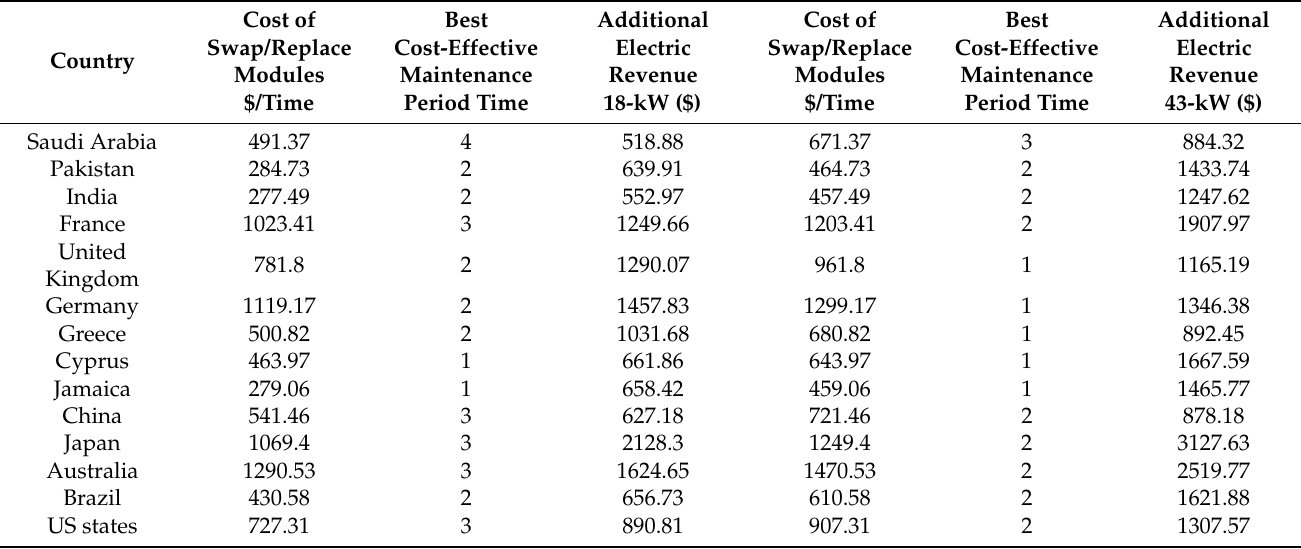
Table 12. The assessment of economic advantage, taking into account the lowest number of times that handling is required.